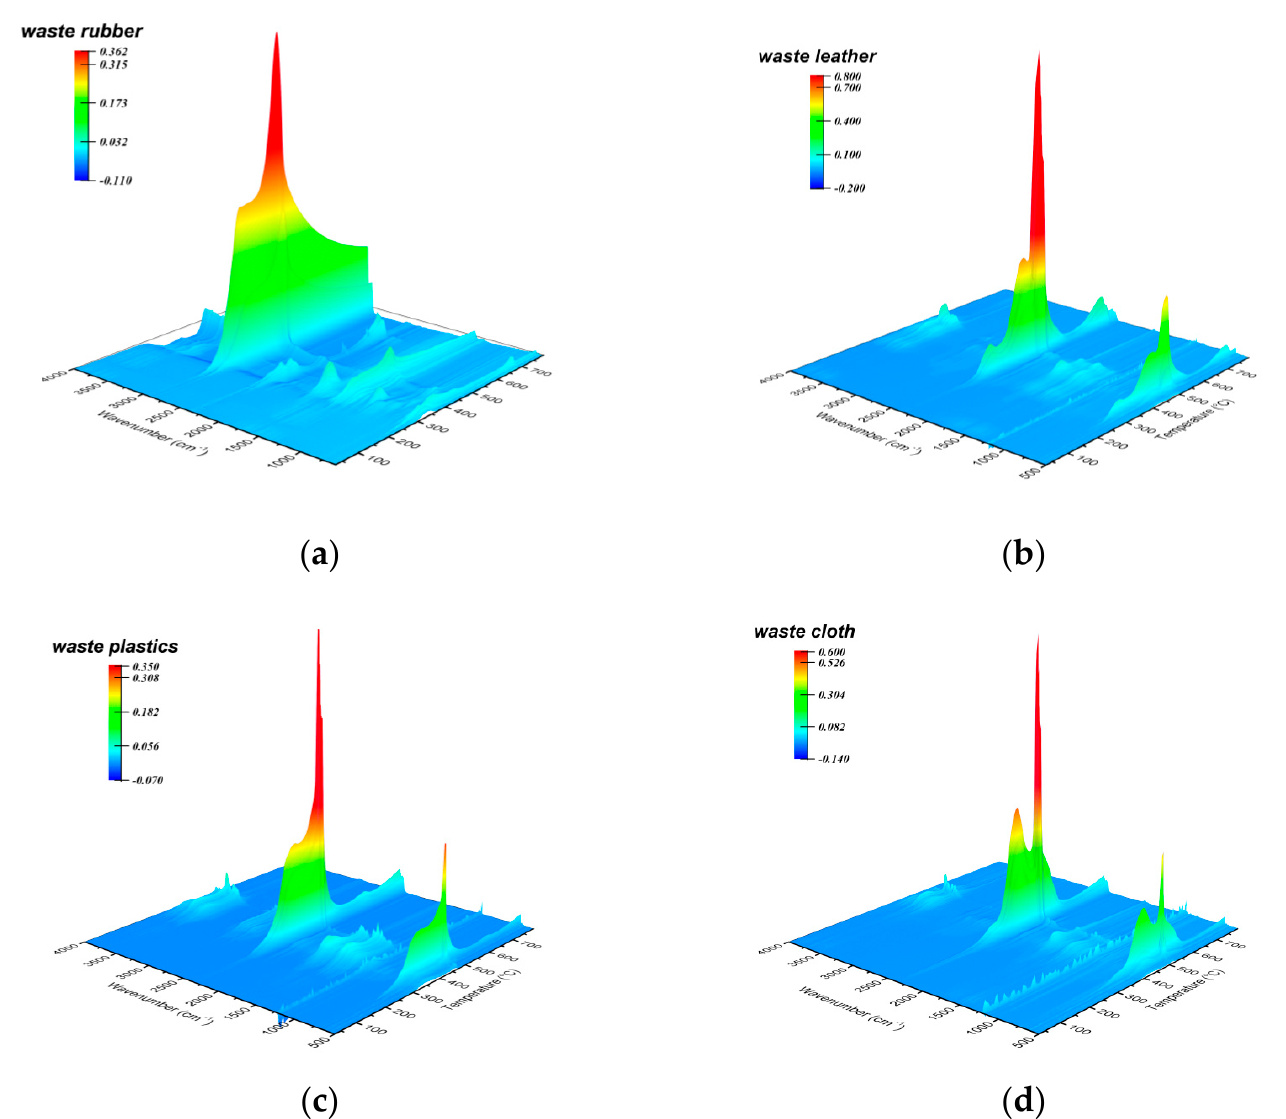
Figure 4. Three-dimensional FTIR spectra obtained from ex situ observation of gaseous volatiles of waste rubber ( a ), waste leather ( b ), waste plastics ( c ) and waste cloth ( d ) at temperature ramps of 20 °C/min.